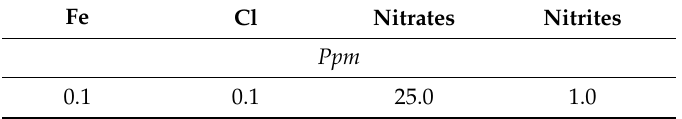
Fe Cl Nitrates Nitrites Ppm 0.1